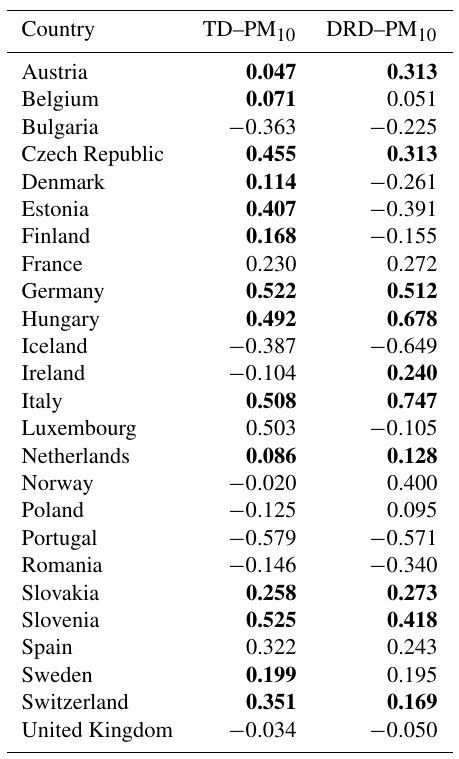
Table 2. Correlation data between total deaths (TD) and PM 10 (left column) and deaths by respiratory diseases (DRD) and PM 10 (right column) for European countries. Bold values indicate a significant correlation ( p < 0 .